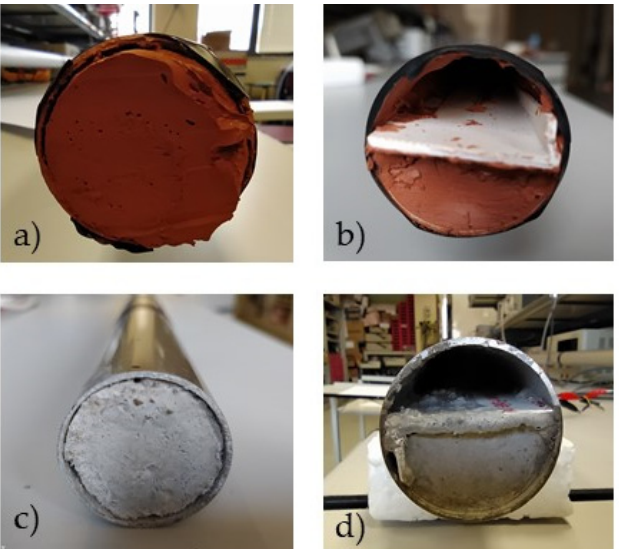
Figure 13. Blockages used: ( a ) and ( b ) total and partial blockages of silicon, ( c ) and ( d ) total and partial blockages of cement.